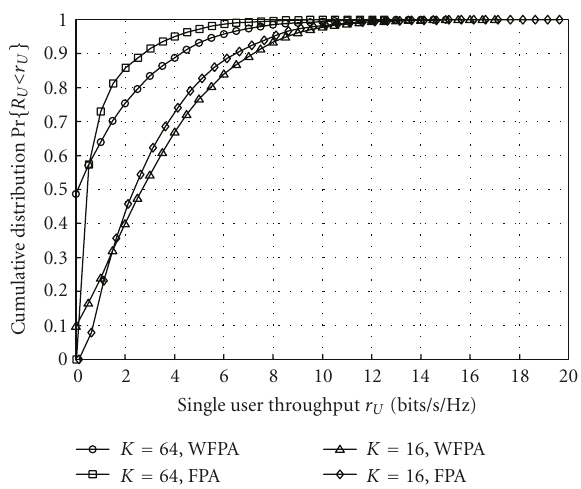
Figure 11: Cumulative distribution of single-user throughput with code constraints for FPA and WFPA (BCRGA in use).